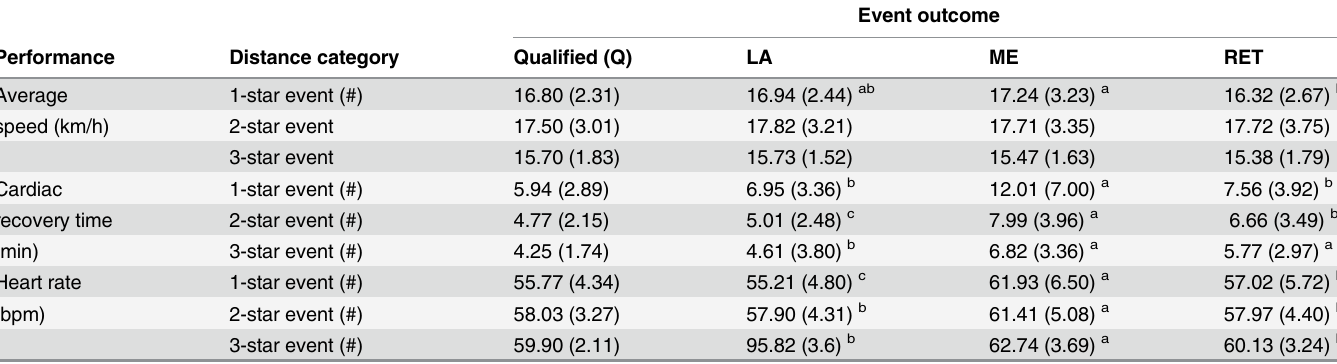
Table 2. The AS, CRT and HR as a function of the outcome of the event, for different distance categories.